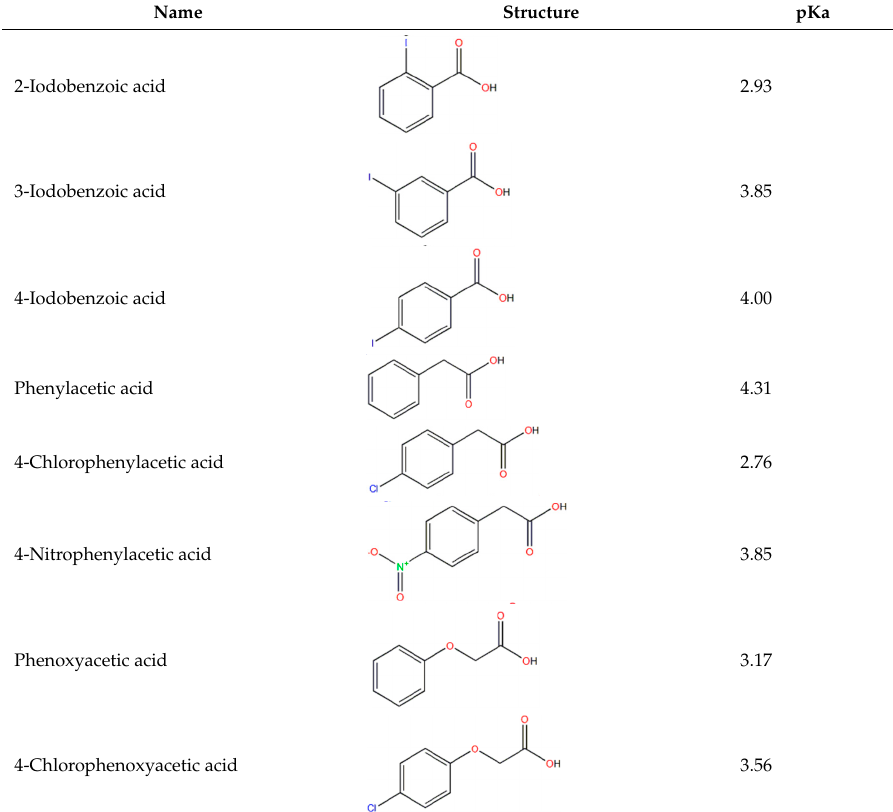
Table A2. Parameters of the genetic algorithm.